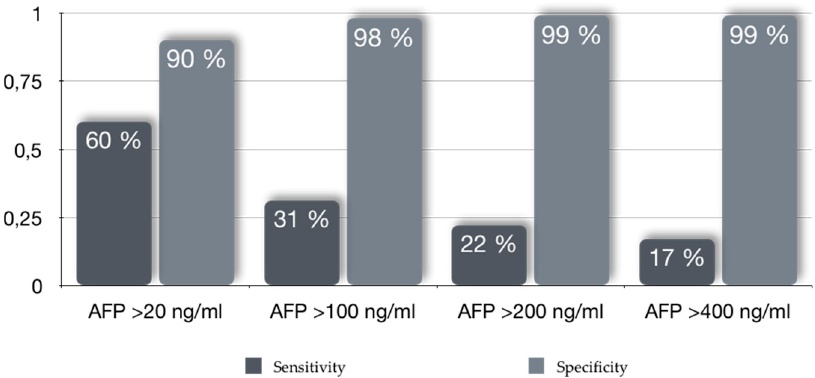
Figure 1. Sensitivities and specificities according to alpha-fetoprotein (AFP) cut-o ff s values for early hepatocellular carcinoma (HCC) diagnosis. 1 Adapted from